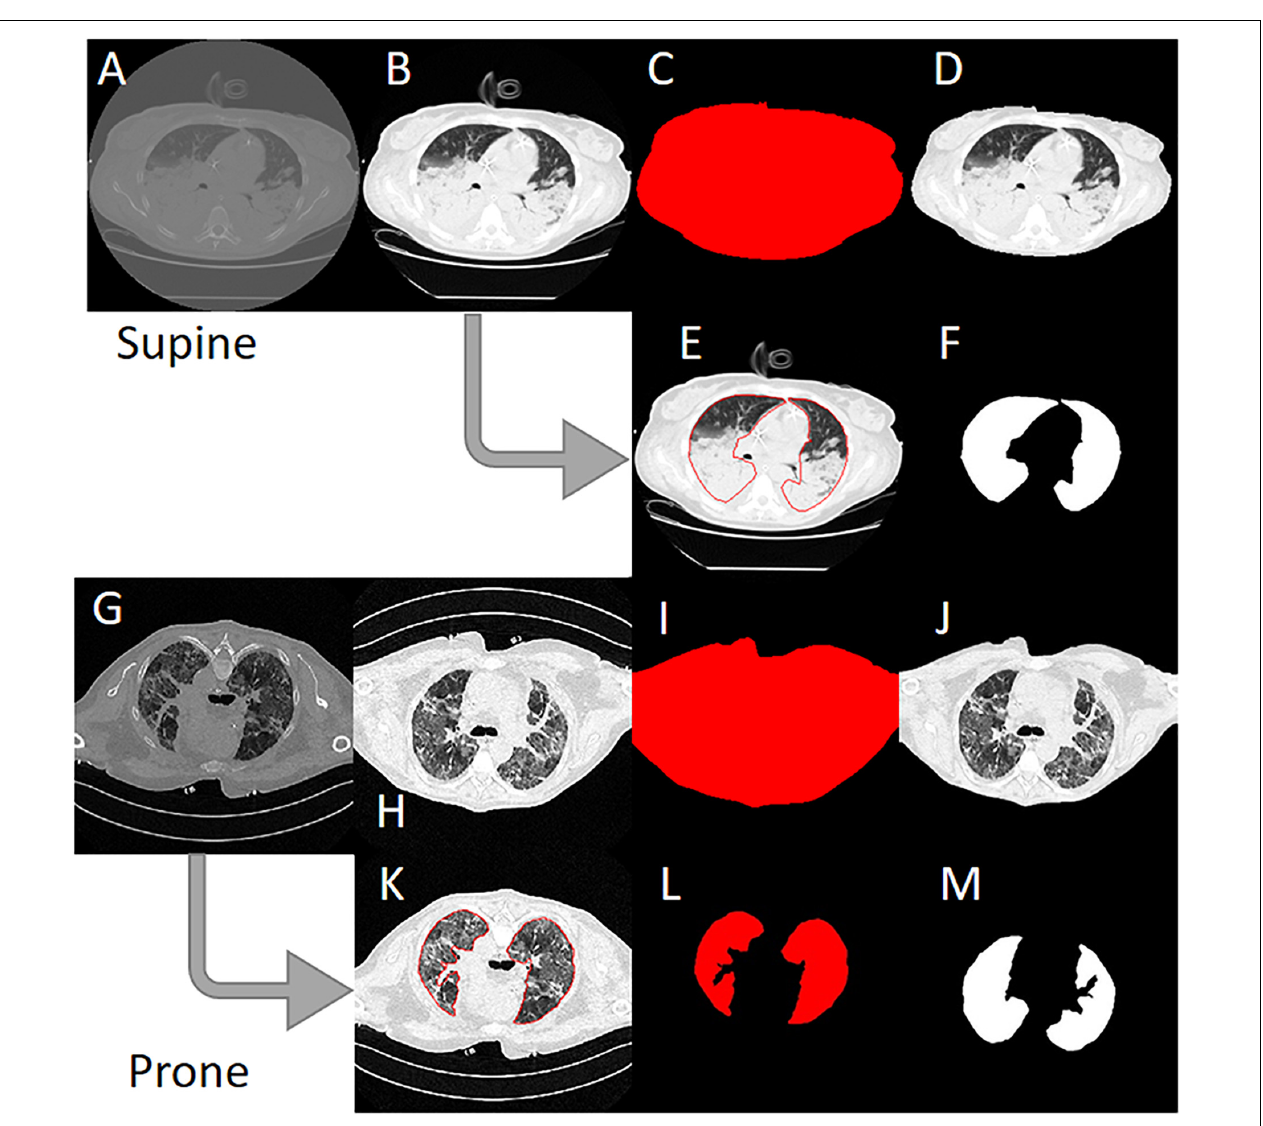
FIGURE 2 | Image preprocessing steps to create the input data for the artificial neural network. (A) Original 16-bit gray value Digital Imaging and COmmunication in Medicine (DICOM) image. (B) 16-bit HU image. (C) 8-bit image. (D) Binary thorax mask. (E) Masked image. (F) Normalized image. (G) Manually drawn ROI. (H) Binary mask created from the region of interest (ROI). (I) Normalized lung mask (ground truth). (K) Rotated prone image. (L) Rotated prone mask.